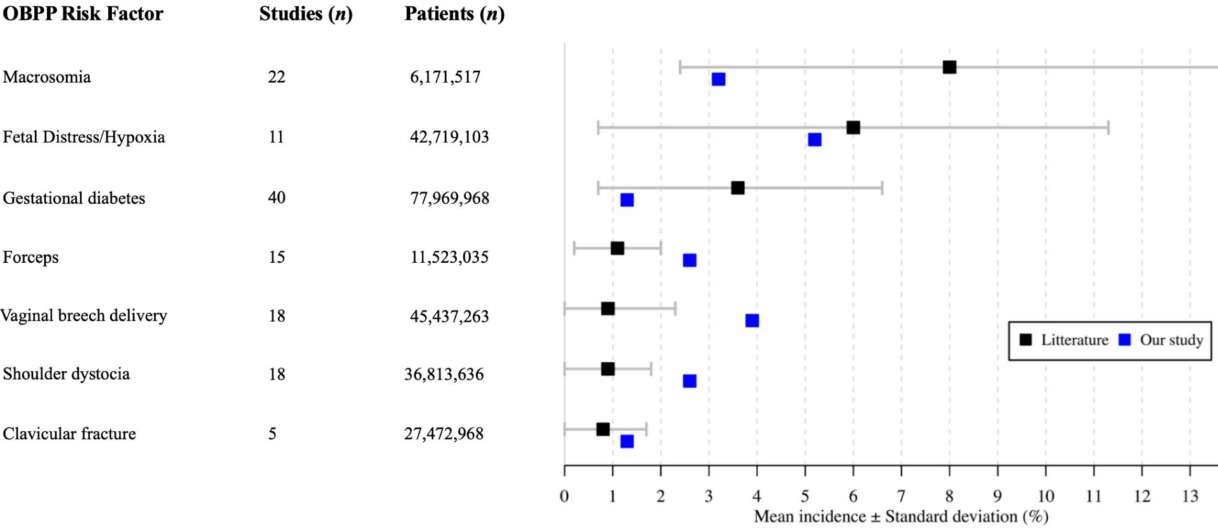
Figure 3. A forest plot comparing the incidence of OBPP-related risk factors between the general population (literature review) and patients with Walch type B shoulder OA (the present